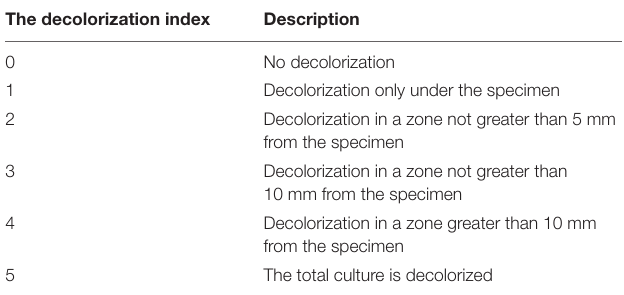
TABLE 2 | The decolorization index.